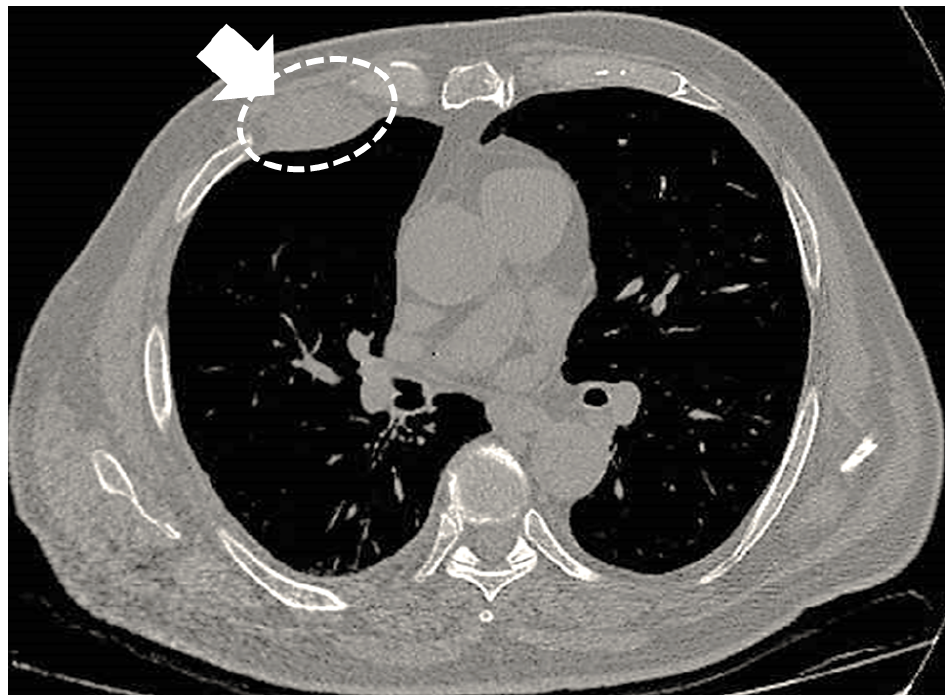
Figure 2. Malignant mesothelioma appearing as a localized mass of the right thoracic wall (arrow and circle).